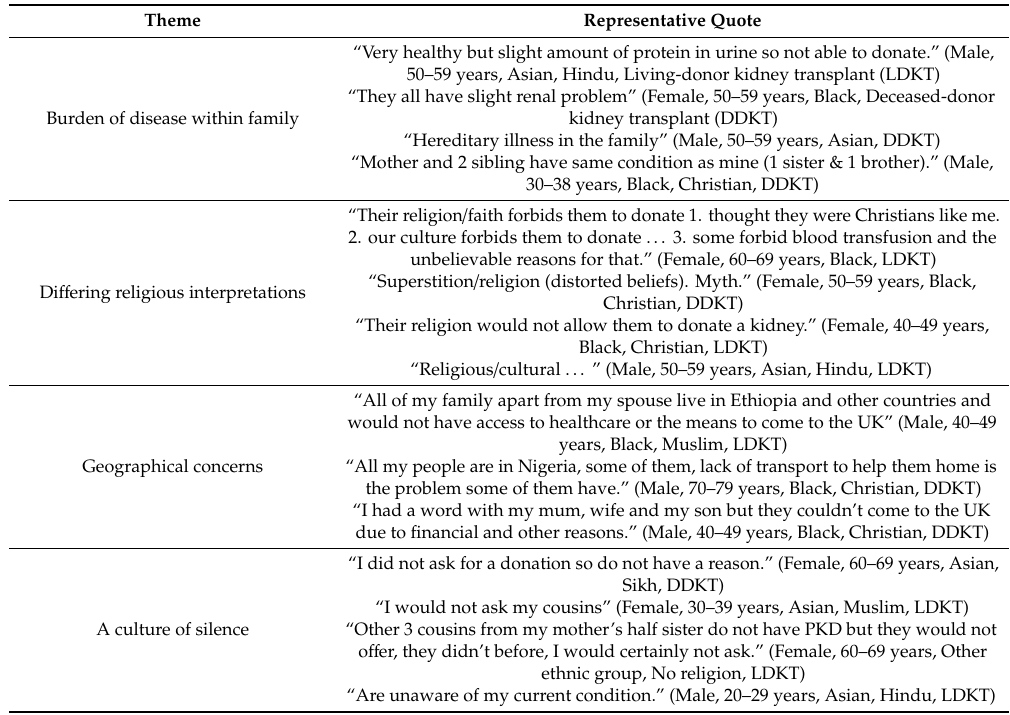
Table 4. UK Black, Asian and minority ethnic participant qualitative analysis themes and illustrative